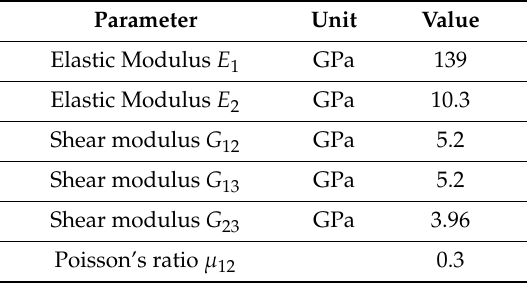
Figure 7. Static analysis model and boundary conditions. Table 1. Material parameters of AS4/PEEK [30].